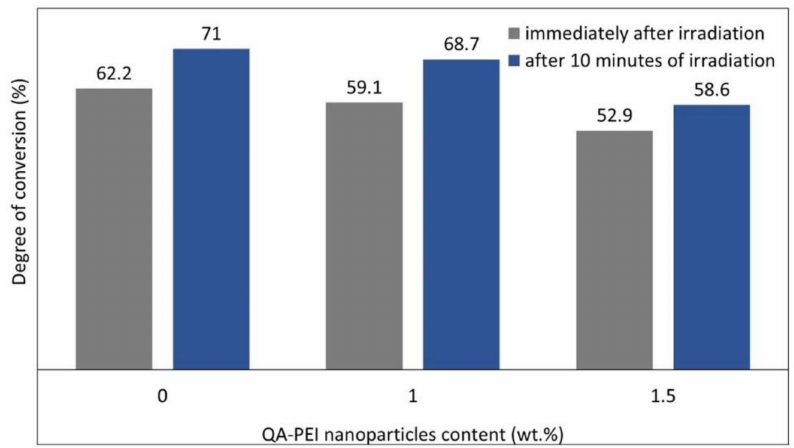
Figure 12. Degree of conversion of orthodontic adhesives modified with QA-PEI nanoparticles. Data from